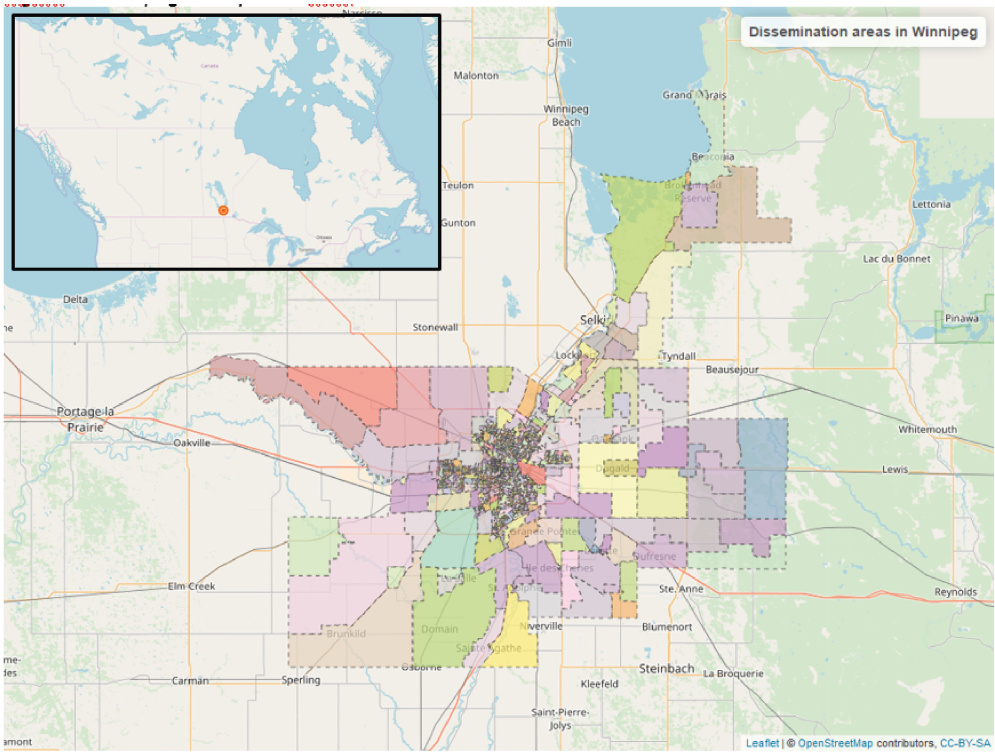
Figure 1: Winnipeg DAs spatial Table 1: Values of fixed parameters in experiment.